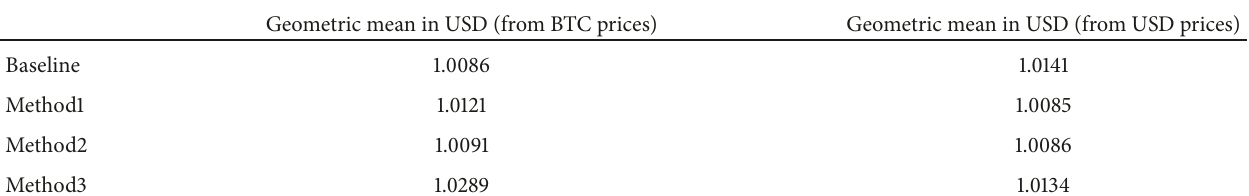
Table 2: Geometric mean returns in USD. Results are obtained for the various methods by running the algorithms considering prices in BTC (left column) and USD (right column).